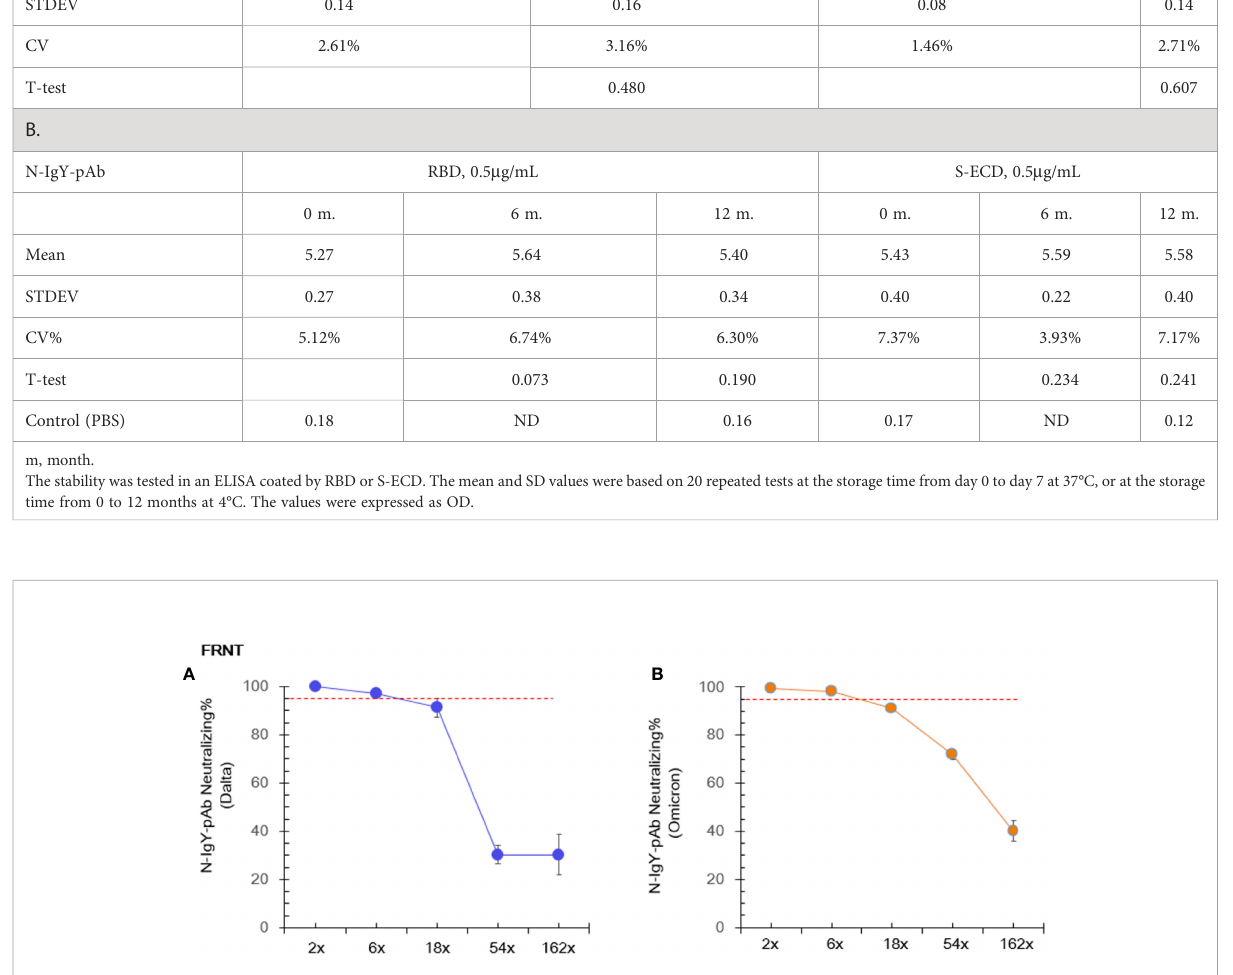
FIGURE 4 Live virus focus-reduction neutralization test (FRNT) involves immunostaining of virus infected cells with a chromogen deposit readout. The novel “ spray ” against the virus variants (Delta: B.1.617.2 (A) and Omicron: EPI_ISL_11799984 (B) was run in Shenzhen Third People ’ s Hospital, China. The mean ± SD was from each sample in replicate three times. The neutralization potential has to be achieved ≥ 95% (red dotted line).